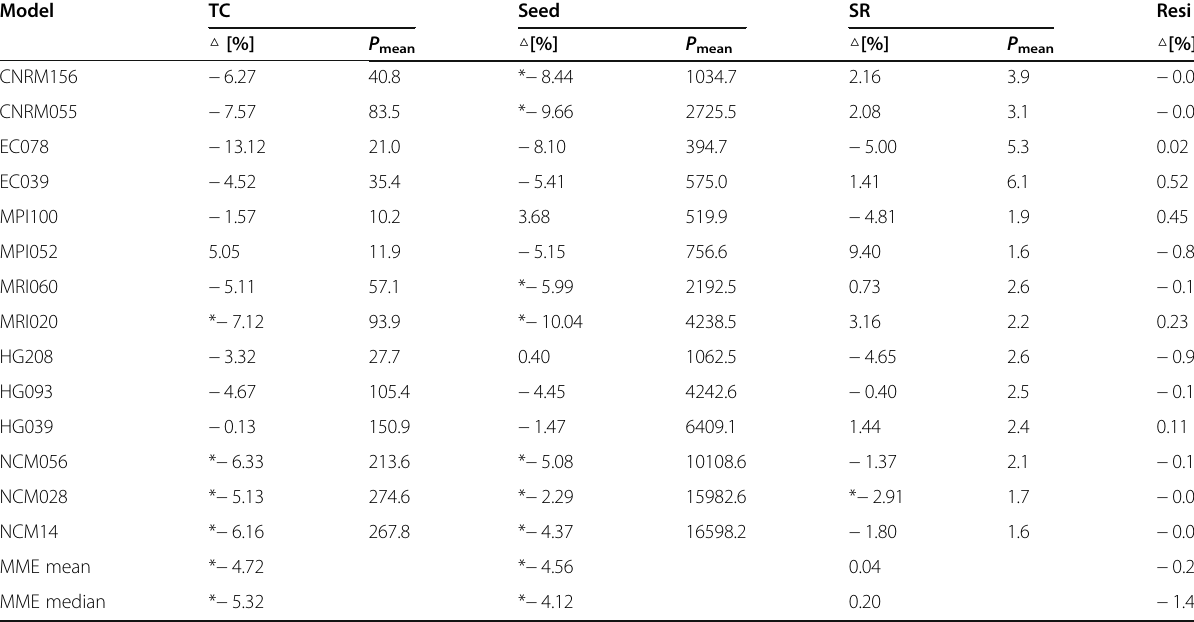
Table 6 Fractional changes in TC genesis frequency, TC seed frequency, and SR